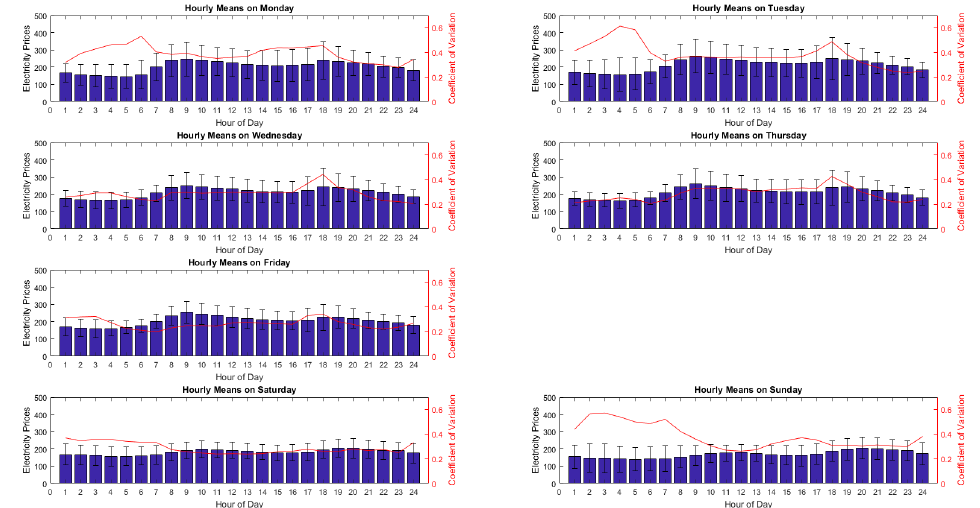
Figure 4. Hourly means for each weekday with coefficient of variation, and the standard deviation bars.